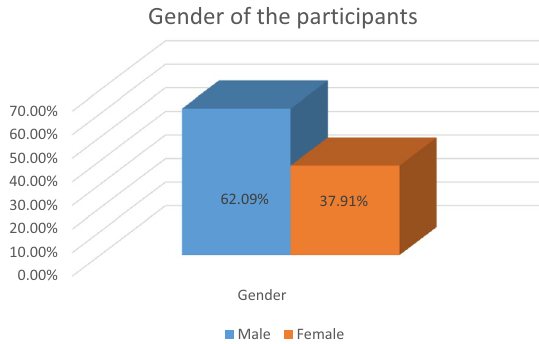
Fig. 1 The distribution of the participants according to their